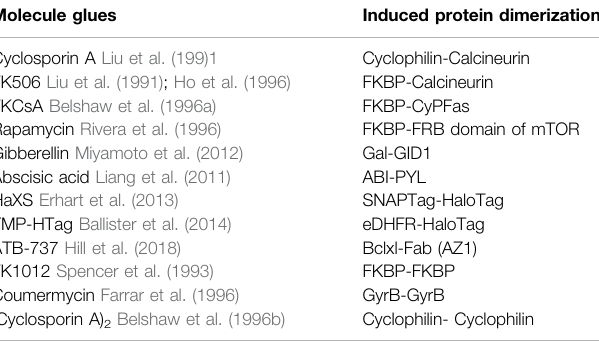
TABLE 1 | Molecule glues-induced dimerization of proteins. Molecule